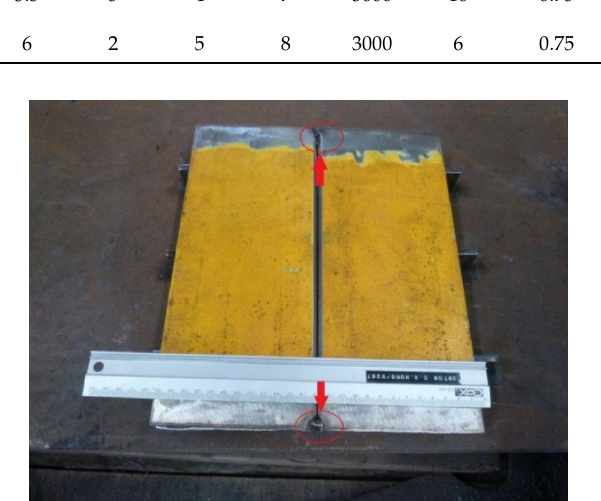
Figure 5. Pre-welding spot to attach the two pieces together for stabilization in the welding process.